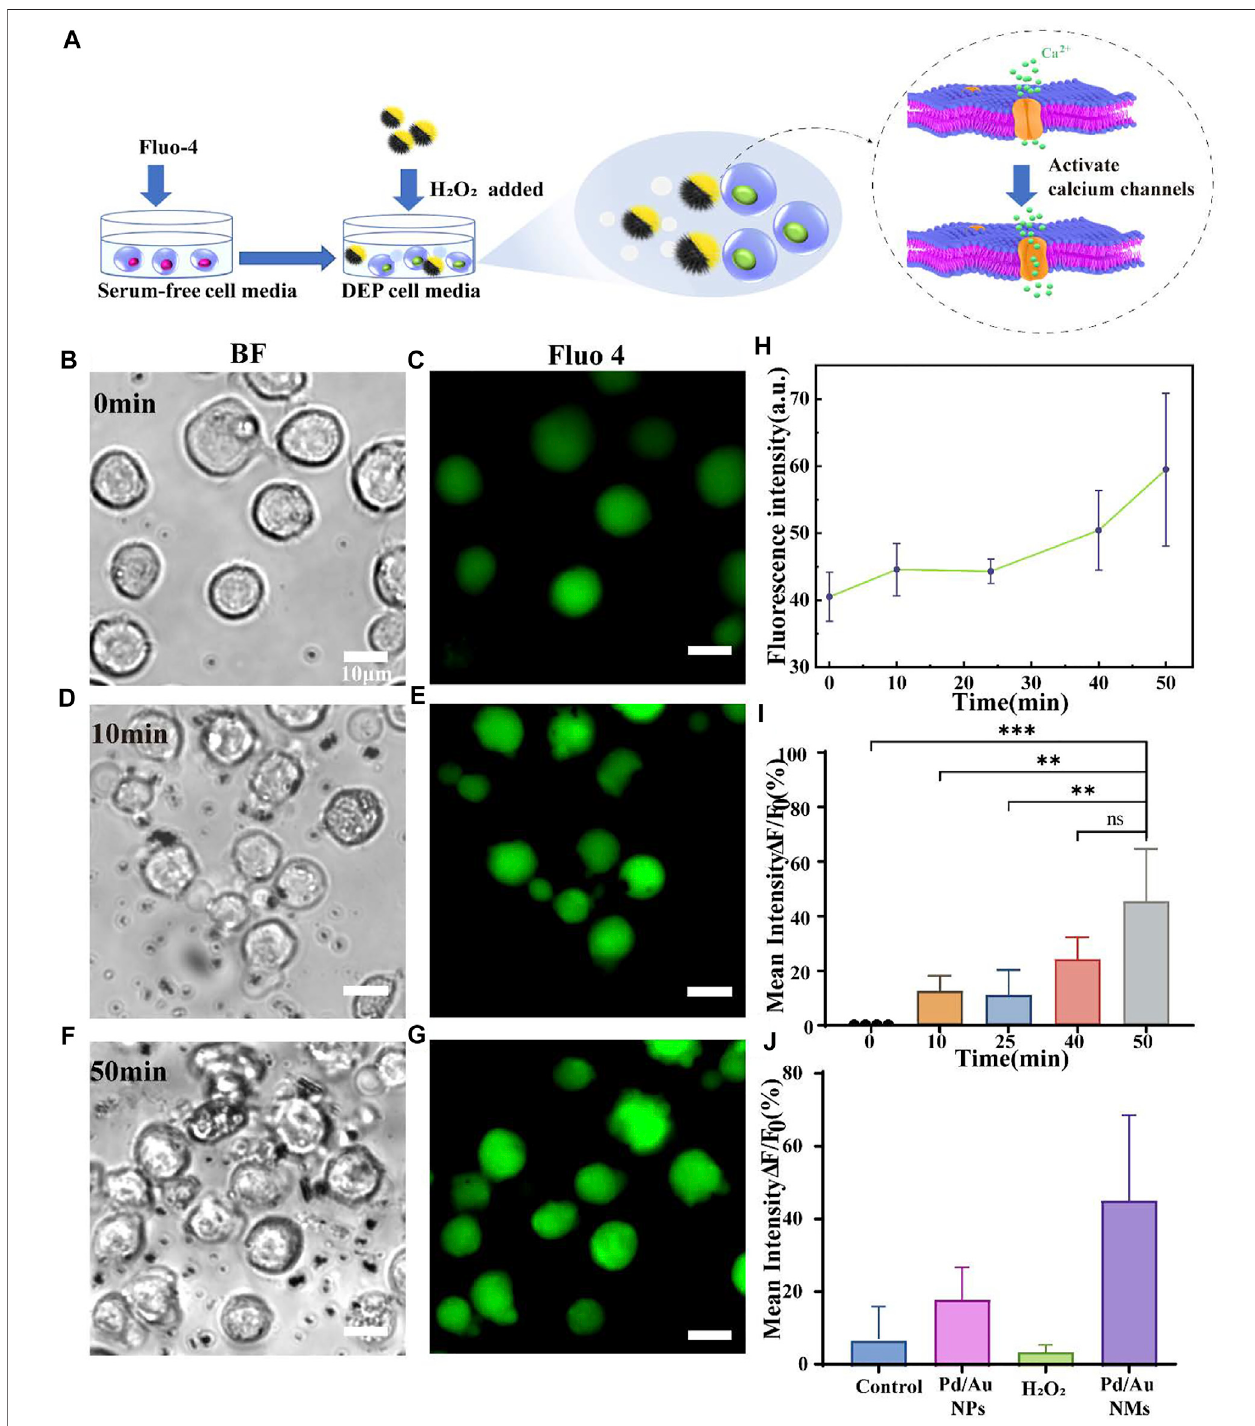
FIGURE 4 | (A) Schematic illustration of the spiky Janus nanomotors to activate T cells via the calcium-permeable ion channel. (B,D,F) Bright- fi eld and (C,E,G) corresponding fl uorescent images showing the interaction between T cells and nanomotors at t = 0,10, and 50 min, respectively. Scale bars = 10 μ m; (H) Plotted the fl uorescence intensity against time is to show the calcium response of Jurkat T cells when incubated with Pd/Au nanomotors ( n = 4); (I) the corresponding increment of calcium fl uorescence intensity over time (relative to the initial time, t = 0 min). The asterisk (*) denotes that the statistical signi fi cance between groups (** p < 0.01, *** p < 0.001); (J) Comparison of the increase in fl uorescence intensity among different groups within the same time interval (50 min): the resting Jurkat T cells, cells with Pd/Au nanomotors (Pd/Au NMs, 0.165 mM H 2 O 2 ), Pd/Au nanoparticles (Pd/Au NPs) and hydrogen peroxide (0.165 mM H 2 O 2 ).